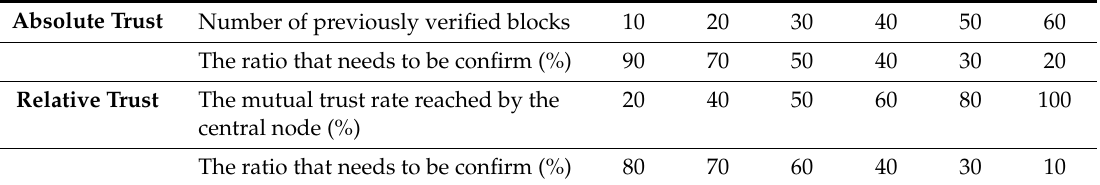
Table 1. Dynamic trust right confirmation